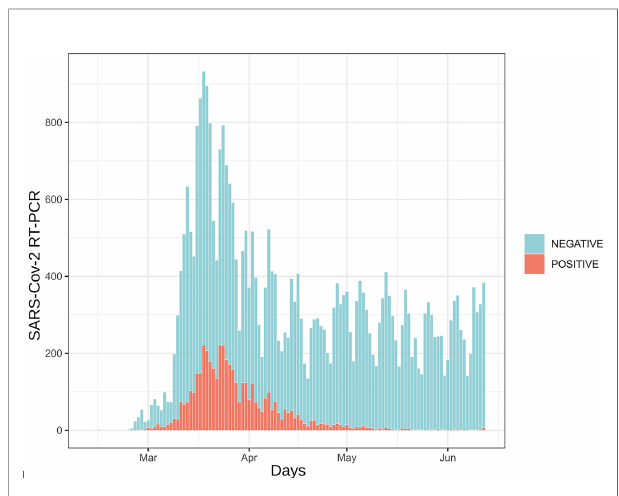
FIGURE 1 | Daily number of SARS-CoV-2 RT-PCR assays. 35,137 analyzes are represented here. Samples are distributed according to their reception date. Blue bars represent samples for which RT-PCR results were negative (88%) while red bars depict positive samples